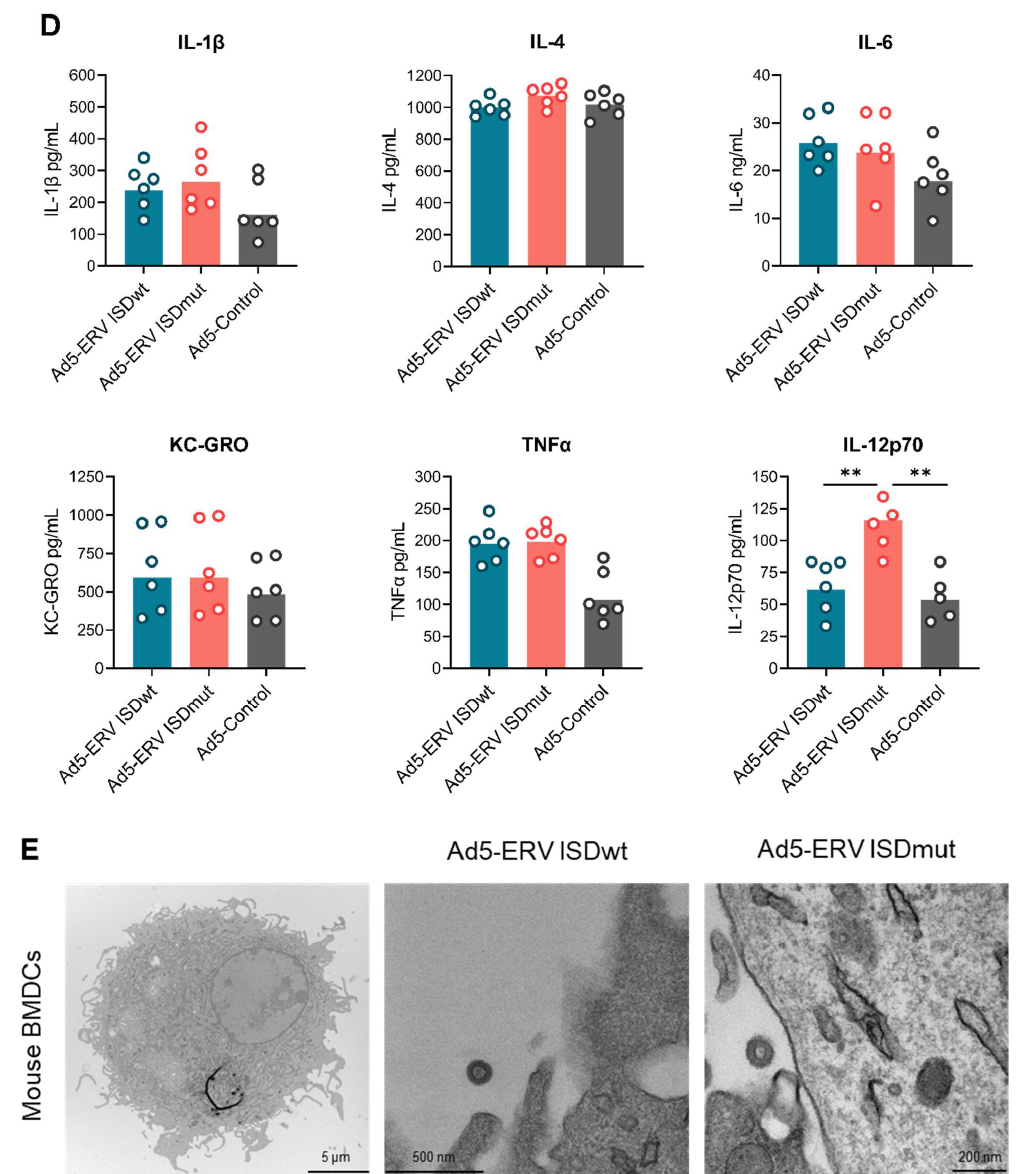
Figure 2. Impairment of the vaccine ISD increases the activation of BMDCs. ( A ) In vitro genera- tion of mature DCs from murine BM cells. BM cells were isolated and differentiated into immature DCs by adding GM-CSF and IL-4 into the medium. DCs were matured by adding CpG and LPS in the culture and transduced at 1000 MOI or 250 MOI with the Ad19a/64- or Ad5-ERV ISDwt or ISDmut, respectively. Ad5- or Ad19a/64-empty vectors were used as negative controls. Twenty-four hours post transduction, the expression of MelARV Env and DC maturation/activation markers was assessed by means of flow cytometry. ( B ) Expression of MelARV Env gp70/SU subunit on the surface of transduced live DCs was assessed by means of flow cytometry using MM2-9B6 d. ( C ) Activation/maturation of live MelARV Env + BMDCs was established by measuring MHCII and CD40 co-expression (fraction of double positive cells) using flow cytometry. ( D ) Secretion of the cytokines IL-1 β , IL-4, IL-6, KC-GRO, TNF- α , and IL-12p70 was assessed in the supernatant of trans- duced mouse BMDCs using a V-PLEX assay. Data points represent samples from 6 independent mice. ( E ) VLPs (of approximately 100 nm size), secreted from mouse BMDCs, were visualized by TEM, 24 h after transduction. Ad19a/64 is referred to as Ad19 in the figure. **: p < 0.01—Mann–Whitney U